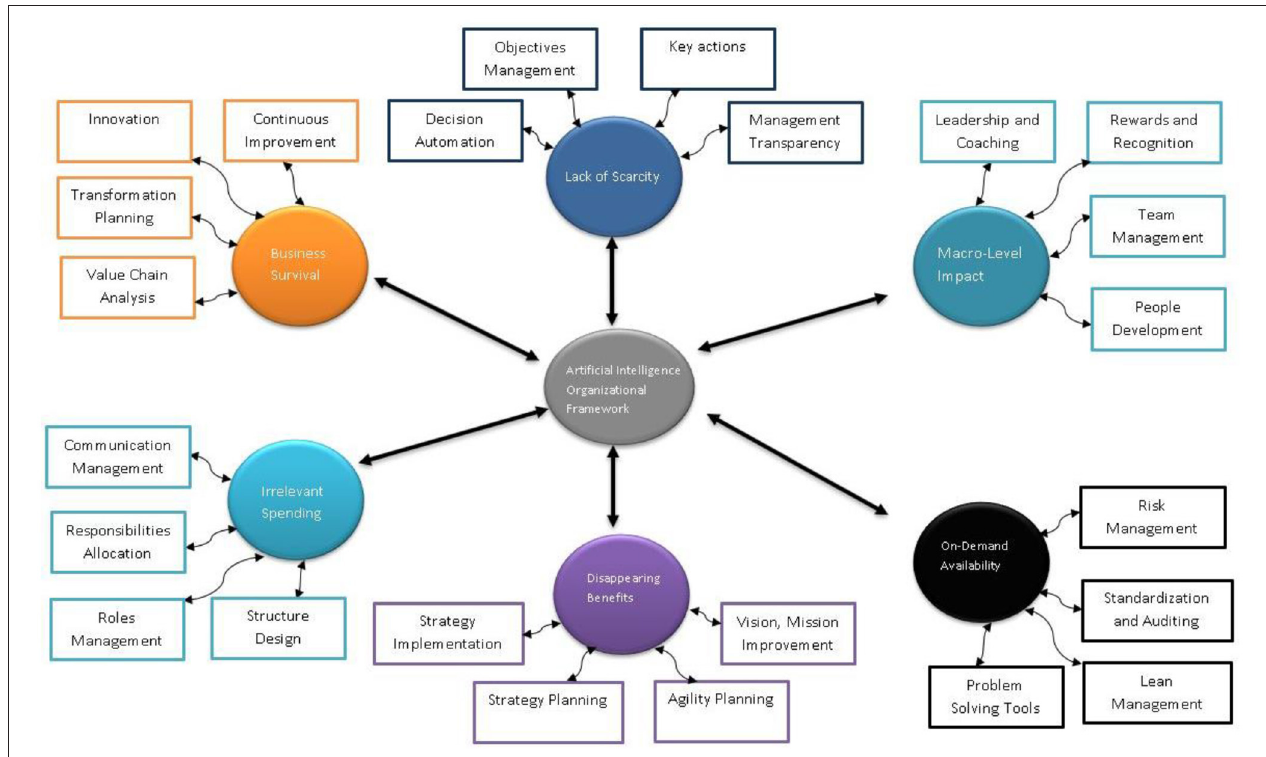
FIGURE 2 | Artificial intelligence organizational